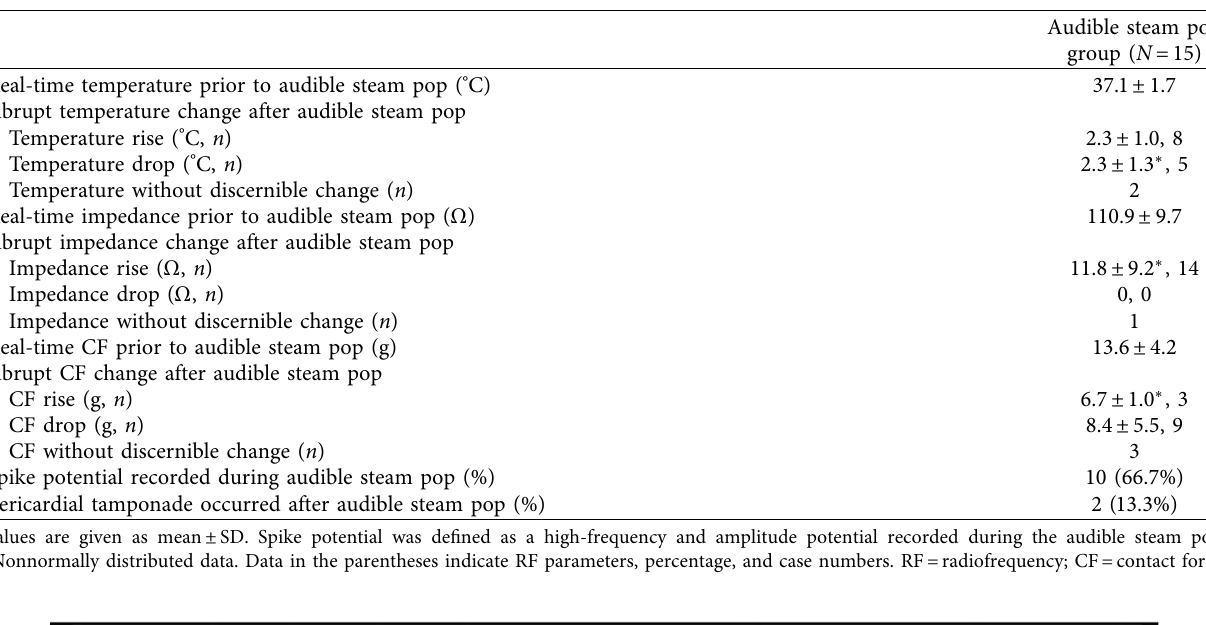
Table 3: RFCA parameters prior to and after the occurrence of audible steam pop during pulmonary vein isolation (power: